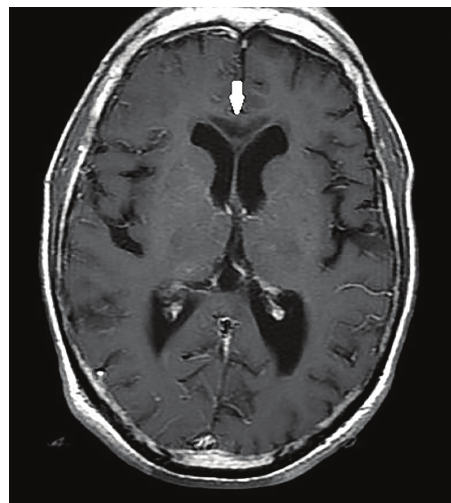
Figure 6: Sagittal fluid attenuation and inversion recovery image displaying central hypointensity (suggesting cavitation) with sur- rounding hyperintense rim (active inflammation) (white arrow- heads) involving the genu, body, and splenium of corpus